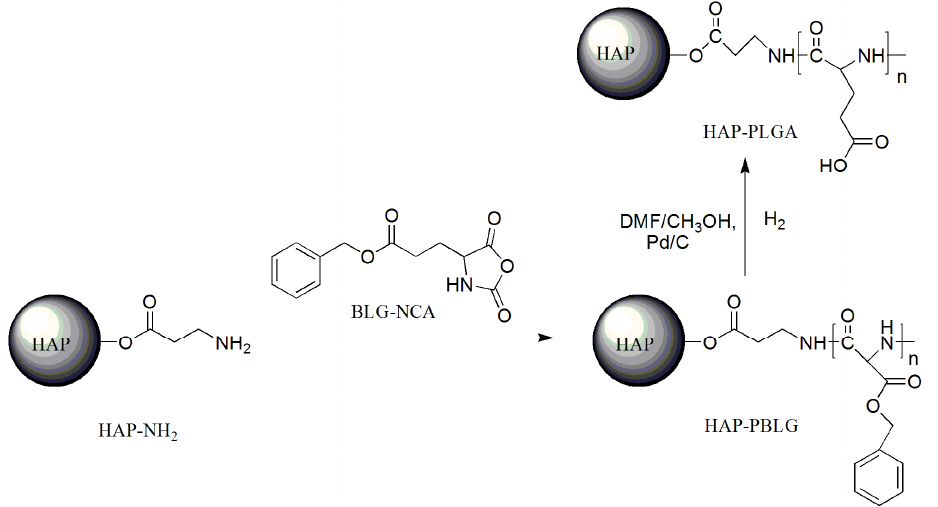
Table 2. Samples synthesized with different molar ratios of BLG-NCA and HAP-NH